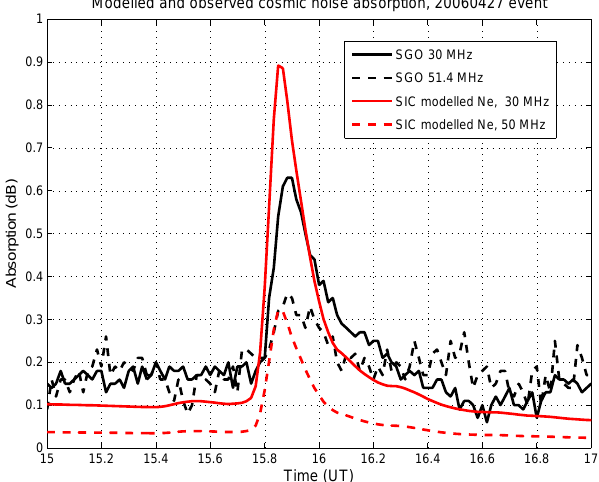
Fig. 10. Comparison of modelled and observed cosmic noise ab- sorption for the 27 April 2006 M-class flare. Red curves: Ab- sorption calculated from SIC modelled electron density profiles and MSISE-90 neutral density and temperature, using the Sen-Wyller formalism. Black curves: Absorption measured by the Sodankyl¨a riometers at 30 and